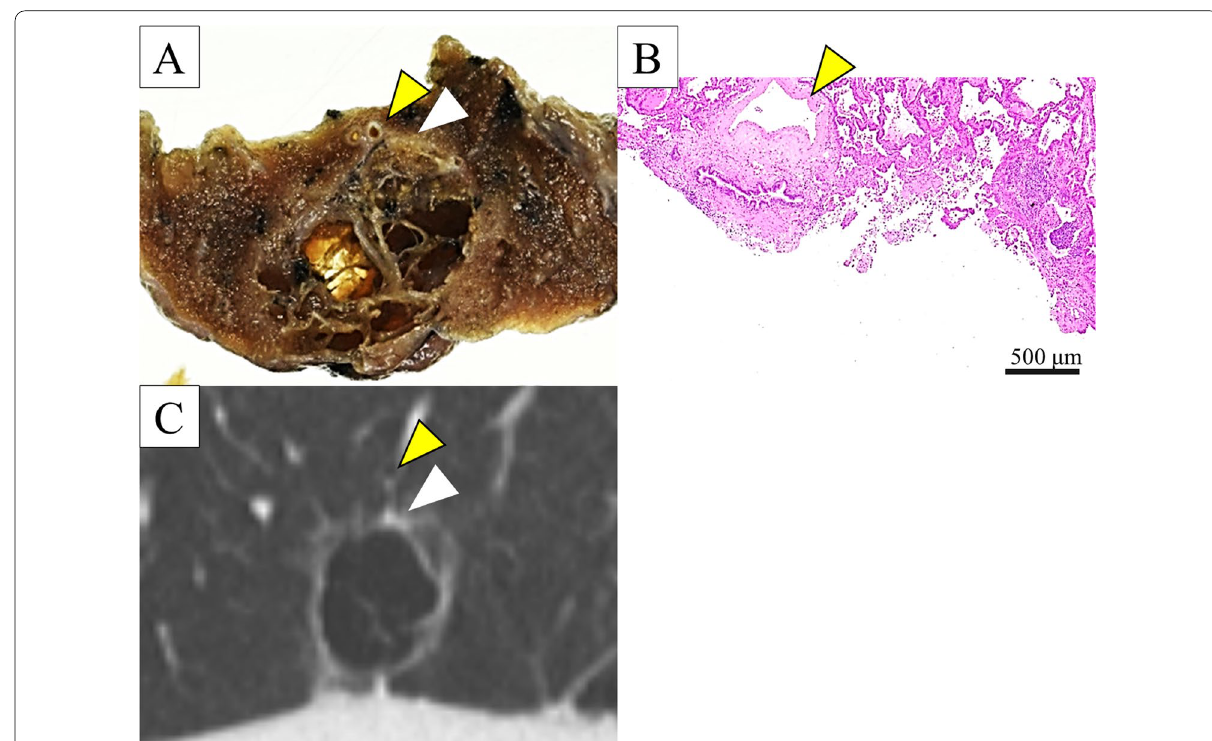
Fig. 3 Detailed analysis of the histopathological and computed tomography scan findings suggestive of check-valve mechanism of cavity formation. a , b Yellow arrows show the bronchi flowing into the cavitary lesion. a White arrow indicates the adenocarcinoma in situ (AIS) detected at the partly thickened area of the cavity. b Microscopic findings showing that the AIS is surrounded the bronchi. c AIS detected on the histopathological findings is consistent with the partly thickened wall of the cystic